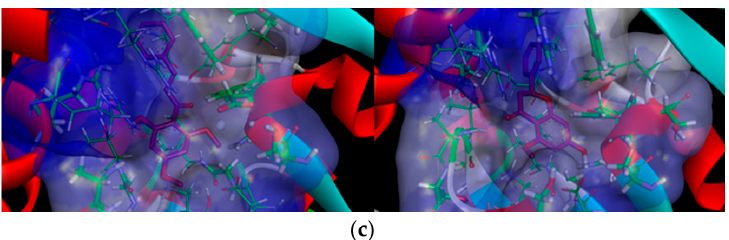
Figure 3. ( a ) Interactions of ligands with UCK2 protein as identified by in silico docking analysis; ( b ) Ligands interacting with the amino acids residues in the active sites of UCK2 protein; ( c ) Surface representation of the hydrophobic contacts of bound ligand and the ligand binding pocket of UCK2 protein shown as translucent blue surface. Ligands shown as a ball-and-stick model with purple indicating carbon atoms, white for hydrogen, and red for oxygen Hydrogen bonds shown in green dotted lines, electrostatic in yellow, and hydrophobic in purple.